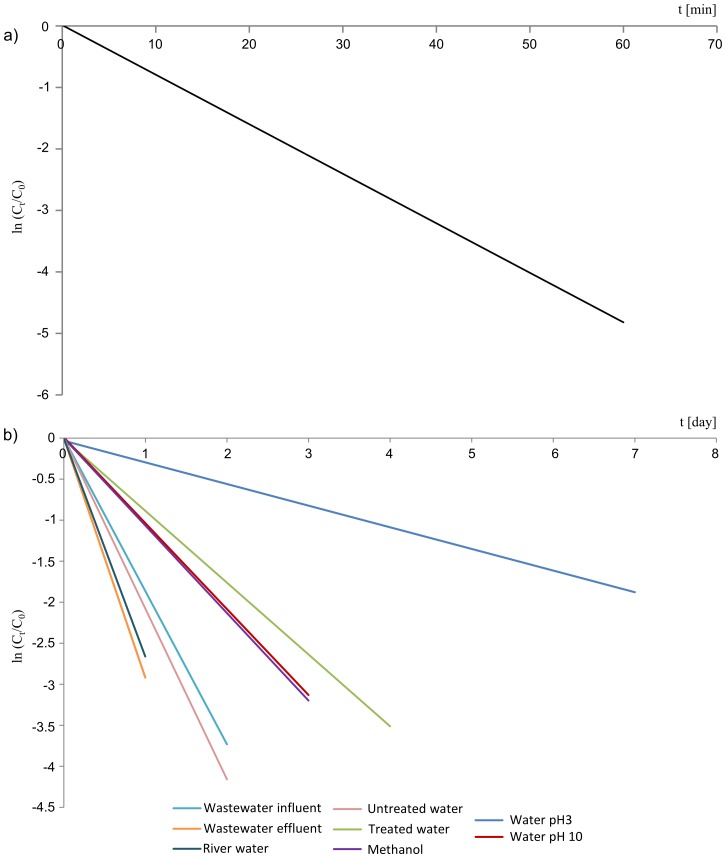
Kinetic curves for AML obtained for various conditions: exposure to xenon lamp irradiation (a) and exposure to natural sunlight including eight different matrices (b).